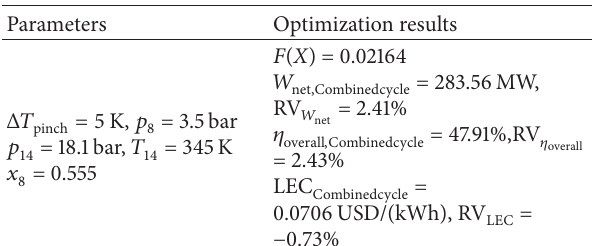
Table 7: Optimization